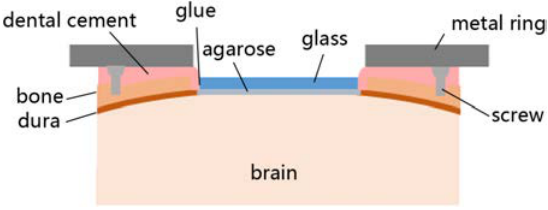
Fig. 1. The schematic diagram of the cranial window. Dental cement was used to ¯x the metal ring to the skull. The screws reinforced the attachment between the metal ring and the